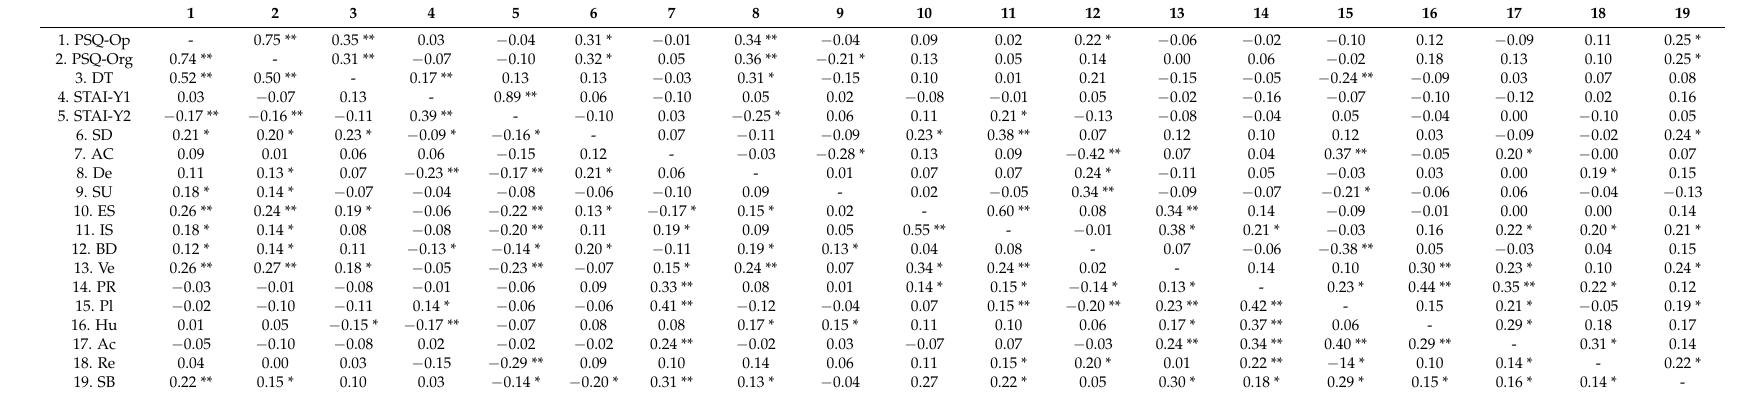
Table 2. Correlation among PSQ-Op and PSQ-Org, Distress Thermometer, STAI Y1 and Y2 forms and Brief